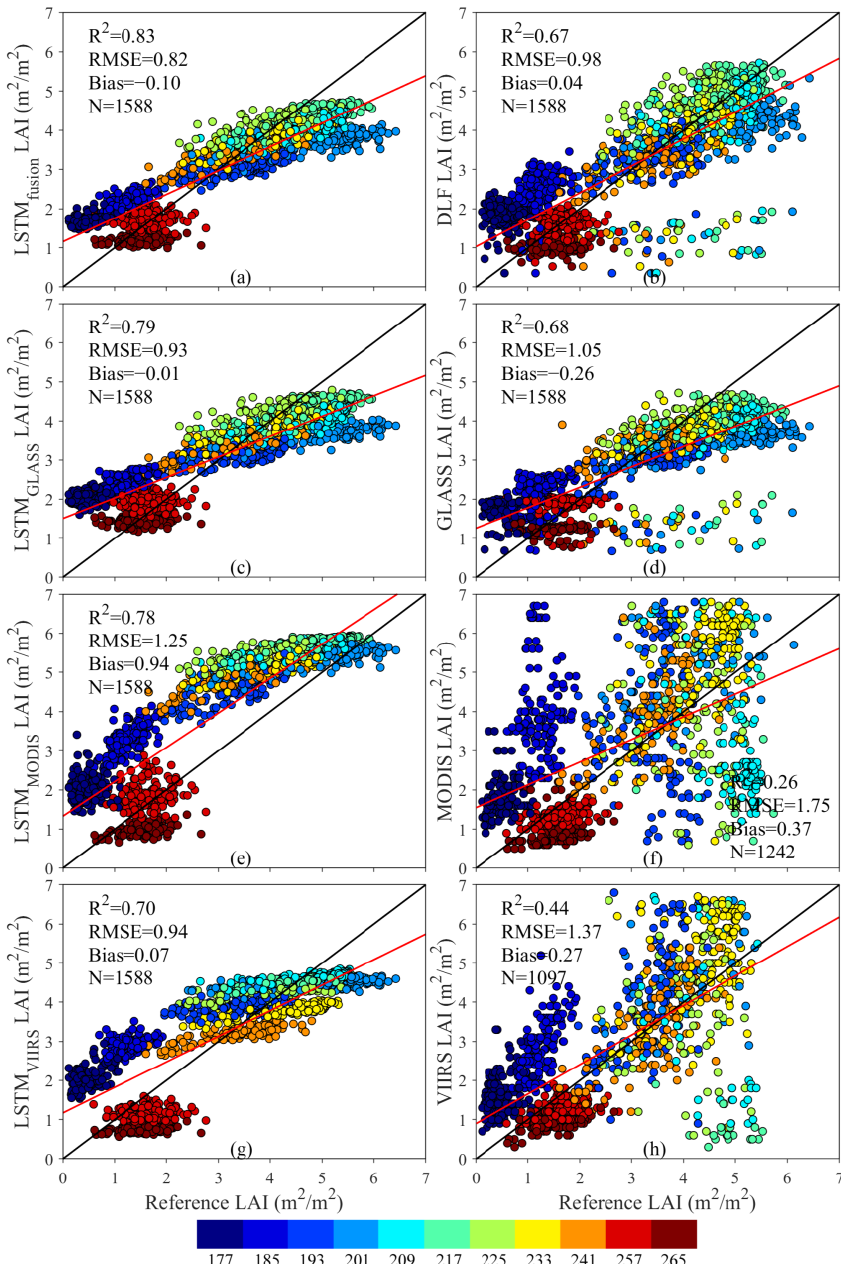
Figure 5. Accuracy assessment (R 2 , RMSE and bias) of the LSTM fusion ( a ), DLF ( b ), LSTM GLASS ( c ), GLASS ( d ), LSTM MODIS ( e ), MODIS ( f ), LSTM VIIRS ( g ), and VIIRS ( h ) LAI values against the reference LAI. The color bar indicates different DOYs in 2016 and N refers to the number of the values for independent validation. Table 3. RMSE between the retrieved and aggregated reference LAI on multiple ground-measured dates in 2016.